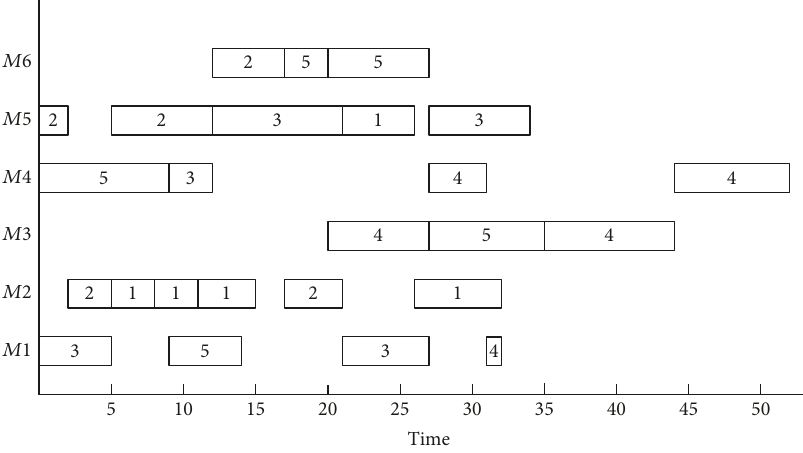
Figure 17: Scheduling Gantt chart for DE2 before optimizing.